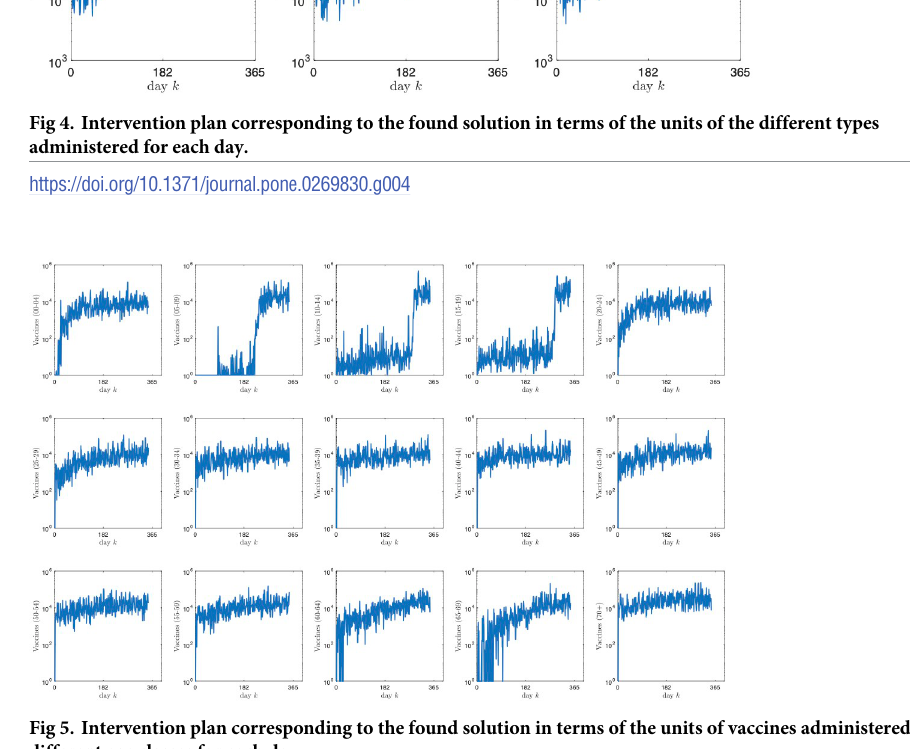
PLOS ONE | https://doi.org/10.1371/journal.pone.0269830 June 14,